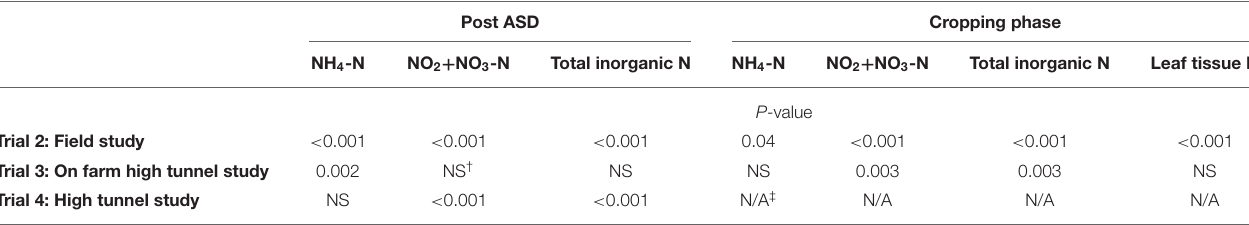
TABLE 3 | Analysis of variance for soil nitrogen and leaf tissue nitrogen response variables after ASD and/or during cropping phase as affected by soil treatment in trials 2, 3 and 4. Post ASD Cropping phase NH 4 -N NO 2 + NO 3 -N Total inorganic N NH 4 -N NO 2 + NO 3 -N Total inorganic N Leaf tissue